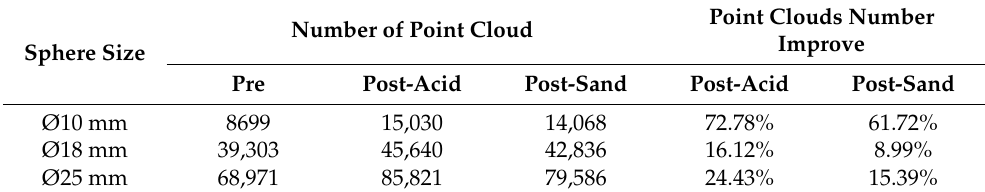
Table 5. Comparison number of points in the point clouds.